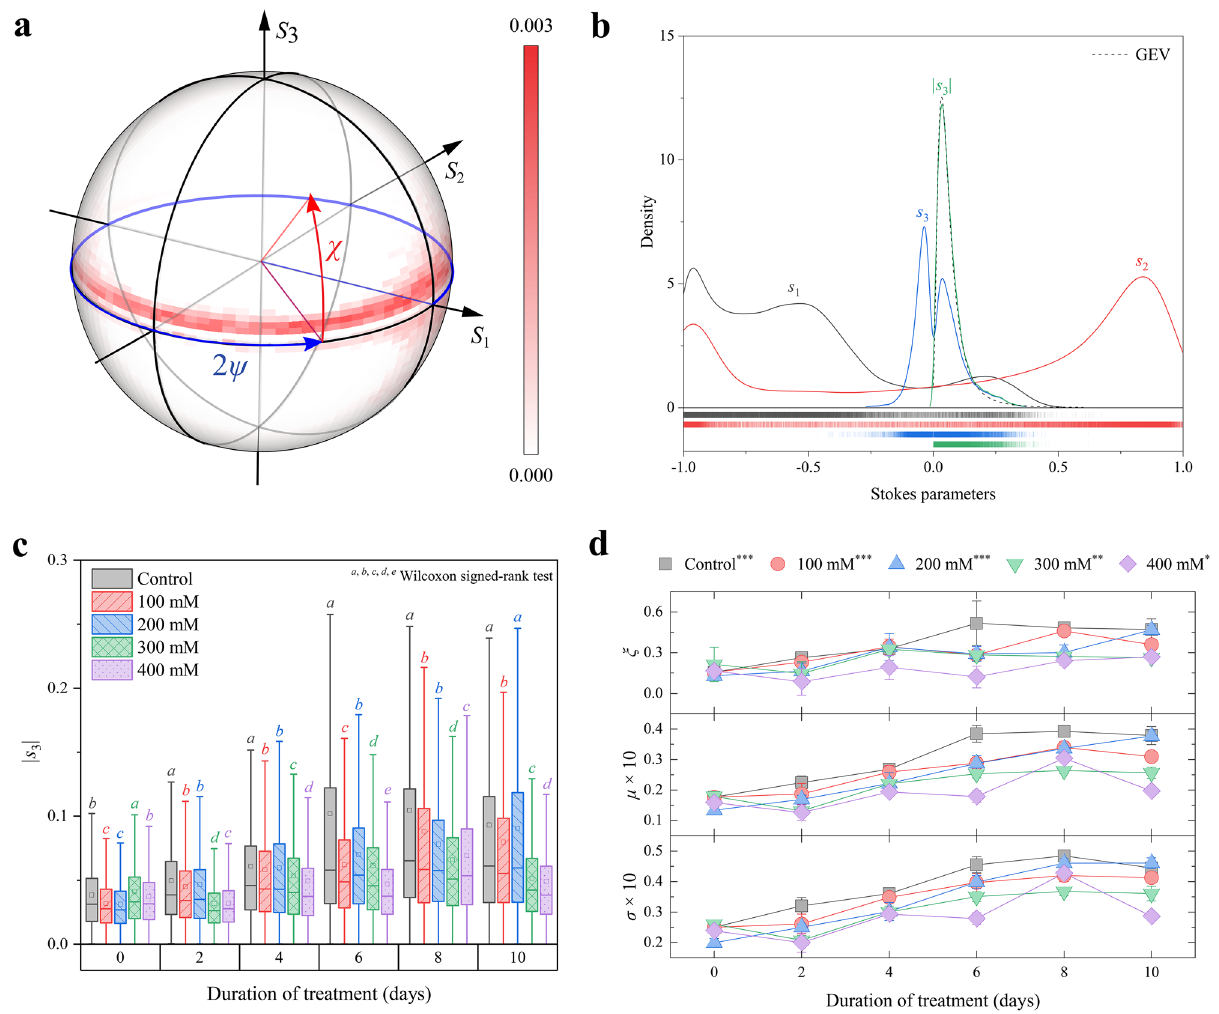
Figure 2. ( a ) Probability density plotted on the Poincaré sphere surface corresponding to polarization states of light after passing through the reference lettuce seedling leaves after 10 days of planting and ( b ) that of Stokes parameters obtained from the reference seedlings. ( c ) Box chart of | s 3 | and ( d ) means of GEV parameters as a function of treatment days for seedlings with different NaCl Meanwhile, the circular polarization component s 3 had two extreme distributions near 0, and it became single when applying the absolute to it (| s 3 |) and was easy to analyze. The distribution of | s 3 | was changed by the NaCl concentration and duration of NaCl treatment, as shown in Fig. 2c. The difference between the distributions was tested by the Wilcoxon signed-rank test at a p-value < 0.001. Because the data did not meet a normal distribution, we used the Wilcoxon signed rank test, a nonparametric statistical hypothesis test. The median and median absolute deviation (MAD) of seedlings are summarized in Table 1. At the beginning of the measurement (day 0), the distribution of the reference and 400 mM seedlings was not significantly different from each of them, and the 100 mM and 200 mM seedlings were also statistically identical. After NaCl treatment, the | s 3 | distributions of the seedlings at the same duration of treatment became significantly different up to 4 groups for the durations of 2, 4, 8, and 10 days. All the distributions (five seedlings) were significantly different from each other at 6 days of treatment. The median and MAD tended to increase over time. Although the median of | s 3 | did not match the concentration of NaCl, it is meaningful that salt-stressed lettuce could be distinguished by measuring the Stokes parameters. If there are seedlings with a significantly lower median of | s 3 |, they can be considered salt-stressed. For example, the median of control seedlings was always higher than that of other seedlings, but the median of seedlings treated with 400 mM NaCl was smaller than that of other seedlings. To find a clearer correlation between the plant state and the polarization state, we tried to fit the data with the generalized extreme value (GEV) distribution. The GEV distribution is widely used to model economic or natural events such as financial risk and rainfall 34 . The probability density function of the GEV is given by,